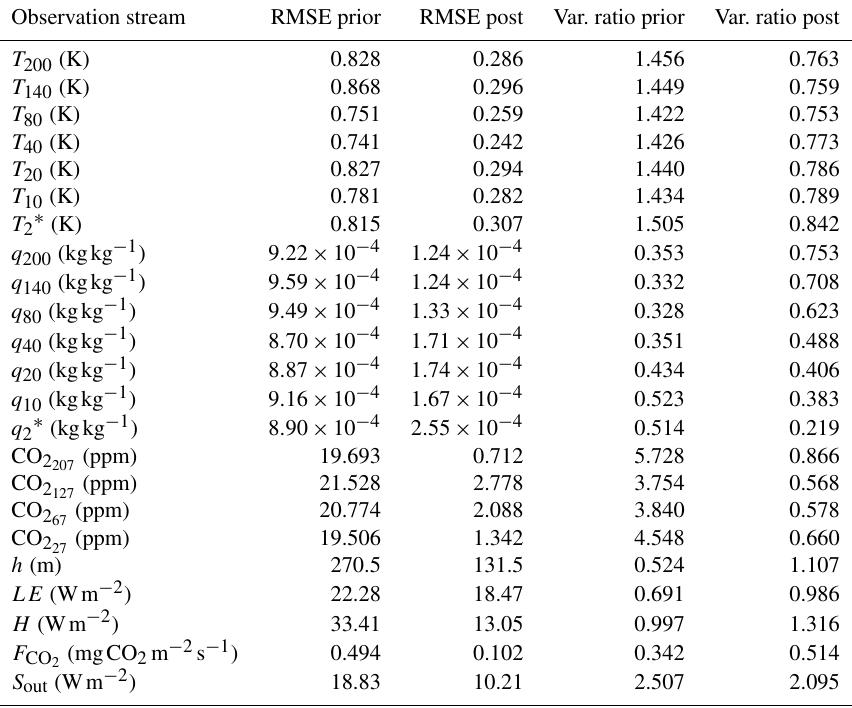
Table 6. Observation fit statistics for the Cabauw optimisation. The left columns show the root mean squared error (RMSE) for the prior and posterior state. The two right columns show the ratio between the model and observation variance for the prior and posterior state. Only model data points for times at which we have an observation available are taken into account. We used a total of 670 individual observations in the cost function. The chosen cost function weights and model and measurement error standard deviations are given in the Supplement. The sensible and latent heat flux observations used are corrected for the energy balance gap (see Eqs. 8 and 9). The observation streams are described in Table A2.